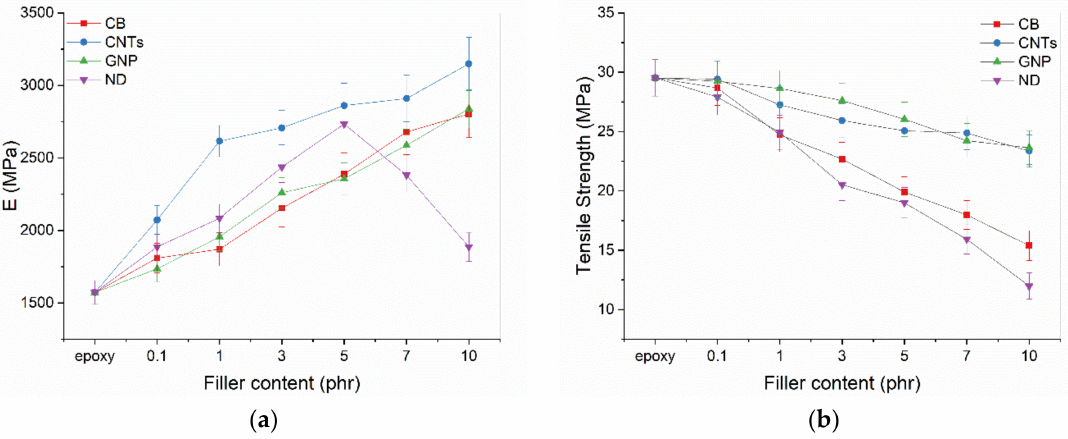
Figure 3. ( a ) Young’s modulus; ( b ) tensile strength versus filler content for all examined